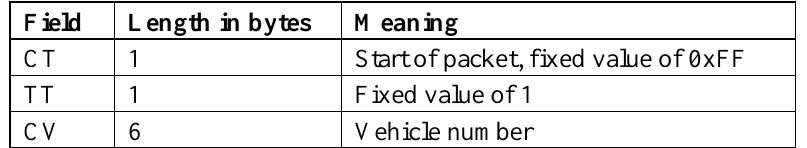
Table 4. Datagram T1.